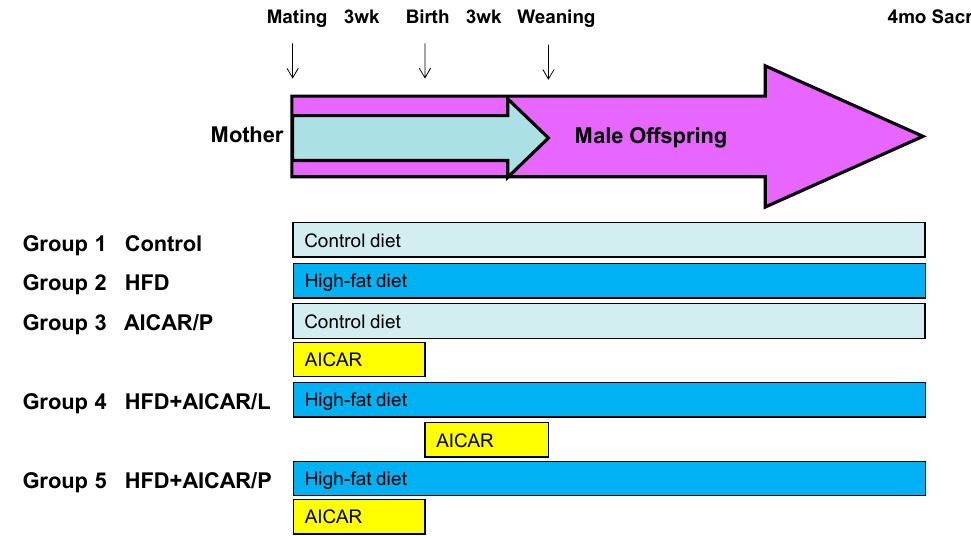
Figure 1. Animal protocol used in the present study.